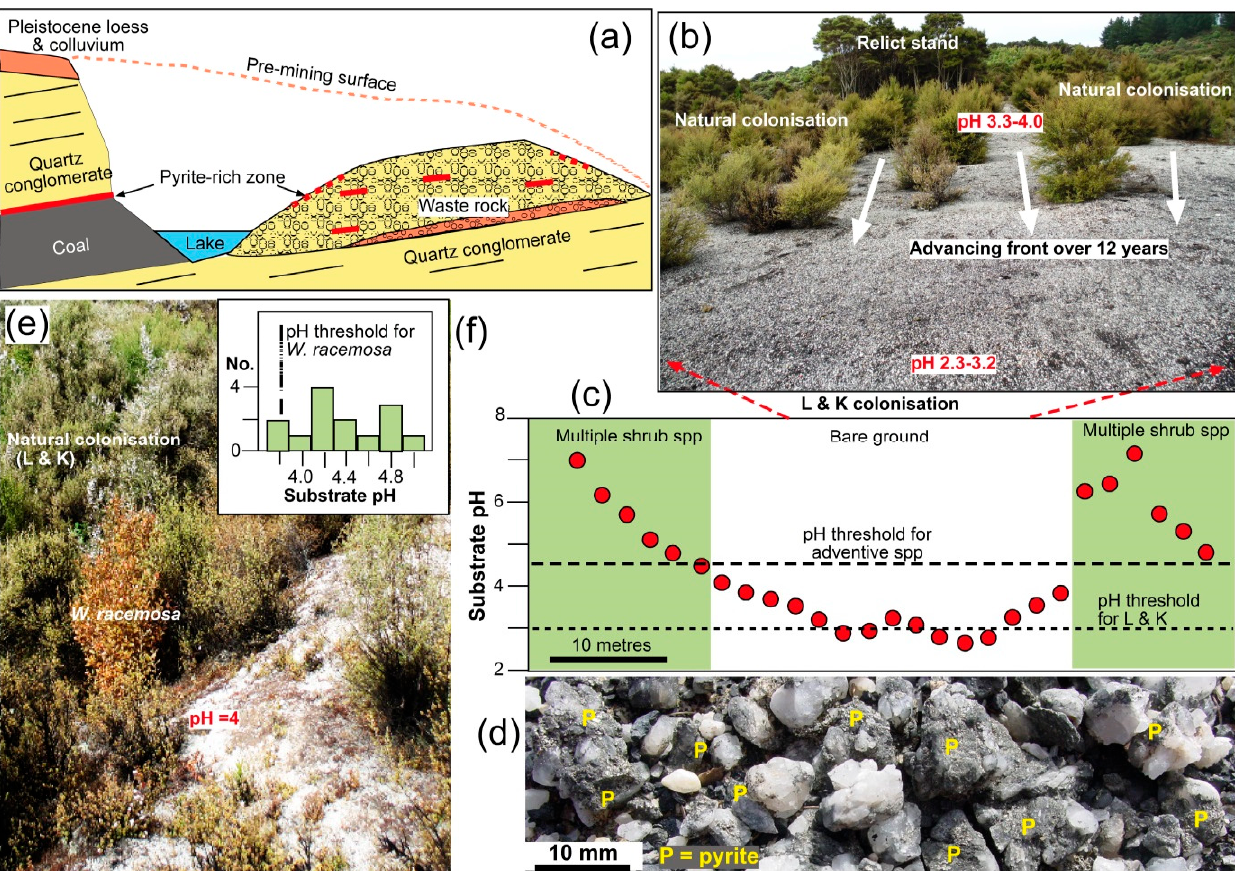
Figure 6. Wangaloa historic coal mine. ( a ) Sketch cross section showing the principal features at present, in relation to the premining topography. ( b ) Photograph (in 2015) of progressive colonisation by L. scoparium and K. ericoides (L and K) shrubs of an acid coal rich debris patch left by the miners. ( c ) Paste pH measurements obtained from substrate samples collected along a transect across the acid patch in ( b ). ( d ) Photograph of pyrite-cemented quartz pebble conglomerate (now disaggregated) from an acid patch of mine waste. ( e ) Photograph of the margin of an acid patch, where L and K colonisation is accompanied by Weinmannia racemosa . ( f ) Histogram of paste pH data from substrates that W. racemosa has colonised.